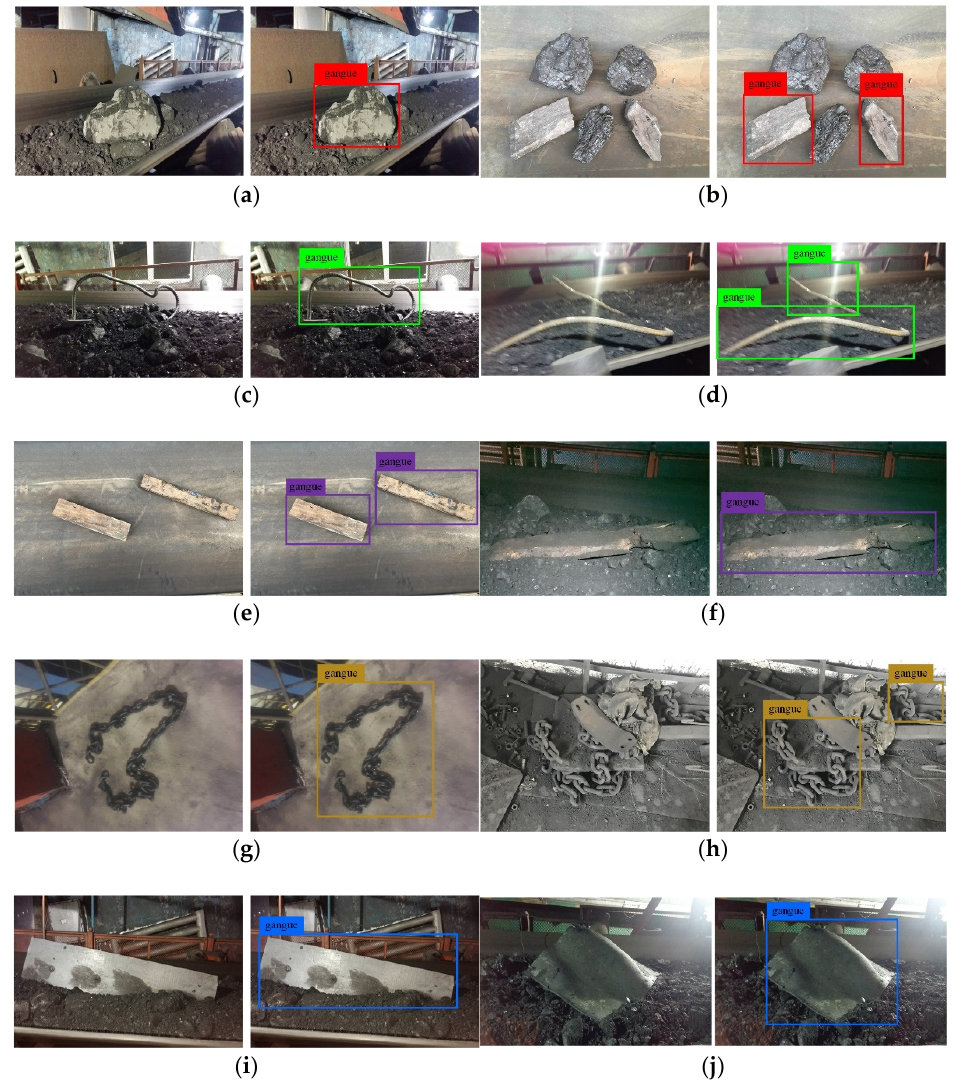
Figure 10. Visualization results. In the sub-figure ( a – j ), the left is the original picture, and the right is the visualization result of the proposed network. The sub-figures ( a , b ) show the detection of gangue; the sub-figures ( c , d ) show the detection of bolt; the sub-figures ( e , f ) show the detection of stick; the sub-figures ( g , h ) show the detection of iron chain; the sub-figures ( i , j ) show the detection of iron sheet.